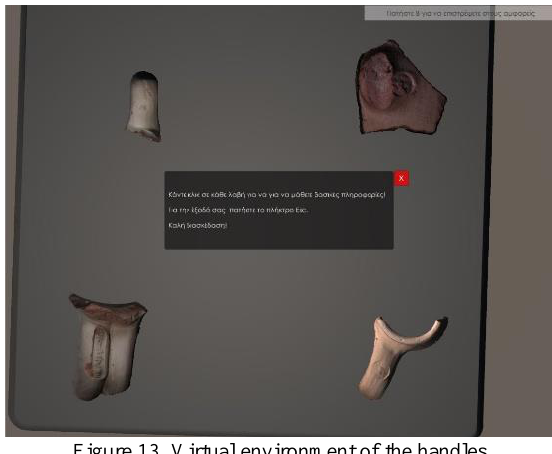
Figure 13. Virtual environment of the handles